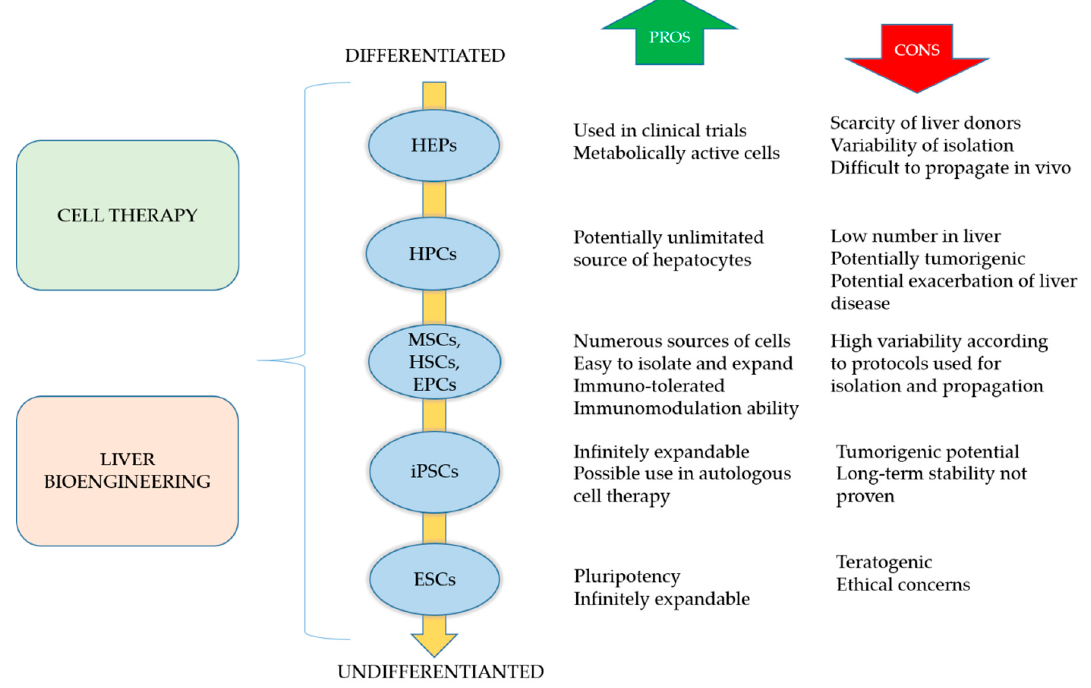
Figure 2. Schematic representation of the principal cell sources available for cell therapy and liver bioengineering, with brief description of their pros and cons. HEPs: hepatocytes; HPCs: hepatic progenitor cells; MSCs: mesenchymal stem cells; HSCs: hematopoietic stem cells; EPCs: endothelial progenitors cells; iPSCs: induced pluripotent stem cells; ESCs: embryonic stem cells.